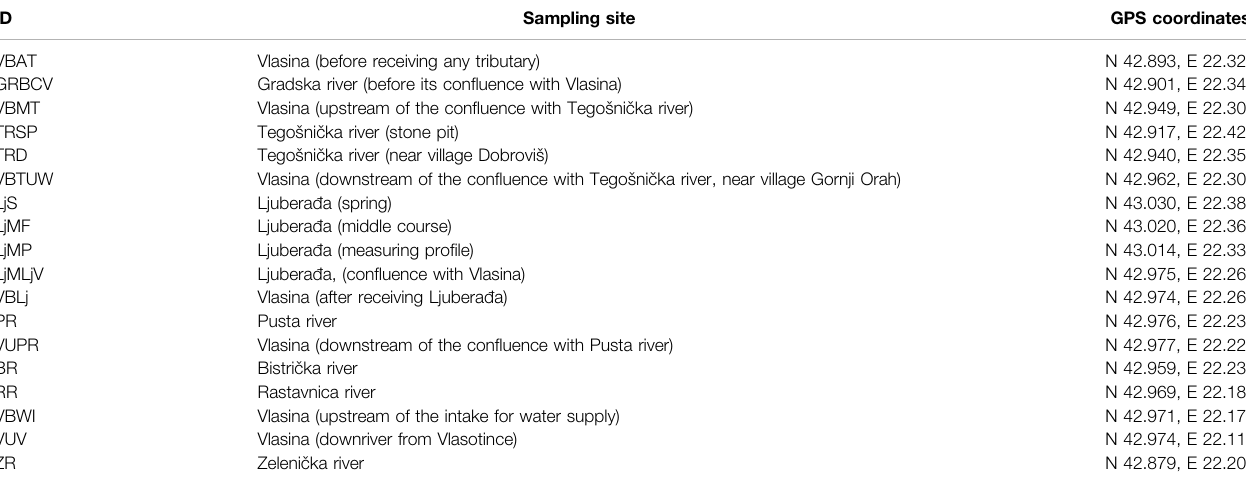
TABLE 2 | List of samples in Vlasina region. ID Sampling